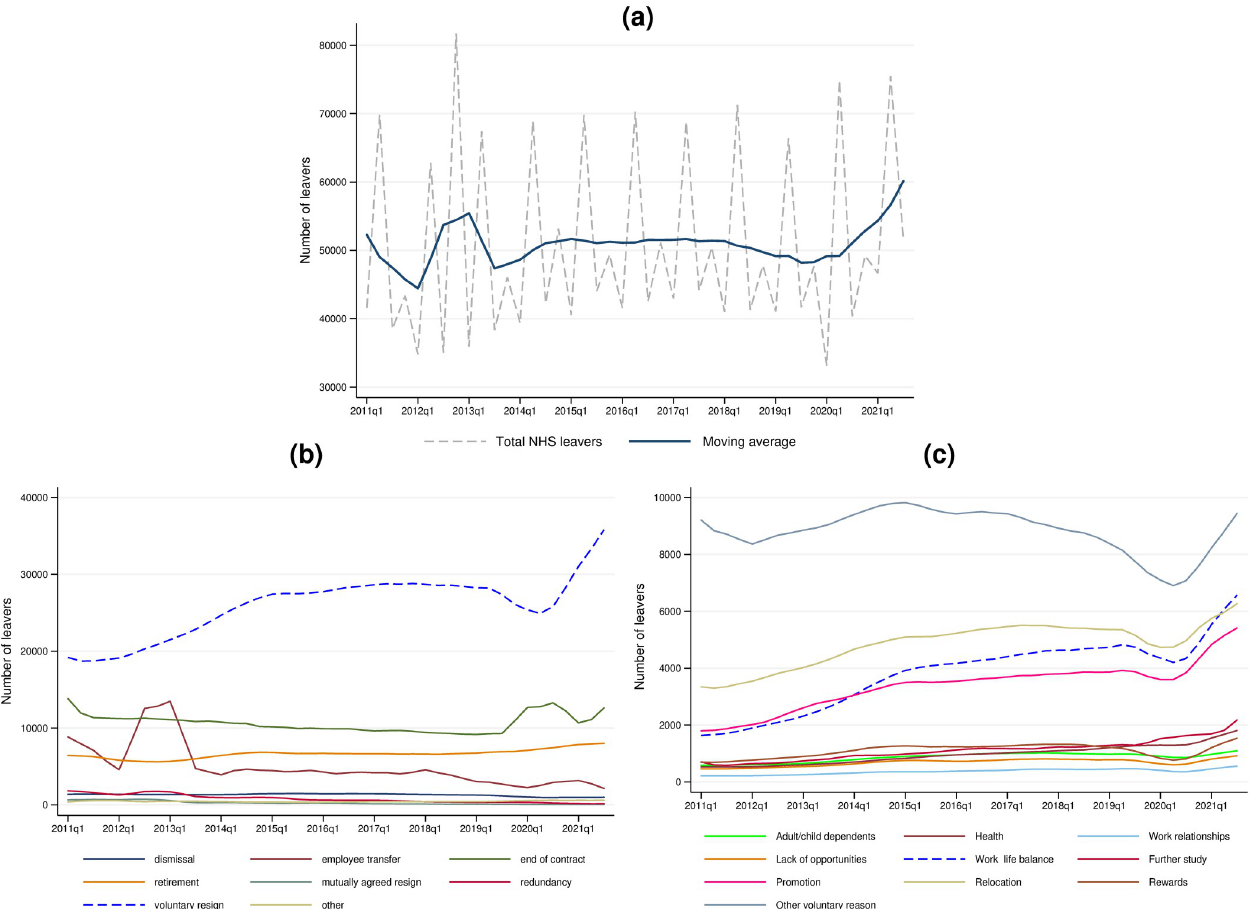
Fig 1. Number of people leaving an NHS job from Q1 2011 to Q3 2021, using NHS workforce statistics. (a) Total NHS job leavers. (b) Breakdown of main reasons for leaving. (c) Breakdown of reasons for leaving voluntarily.